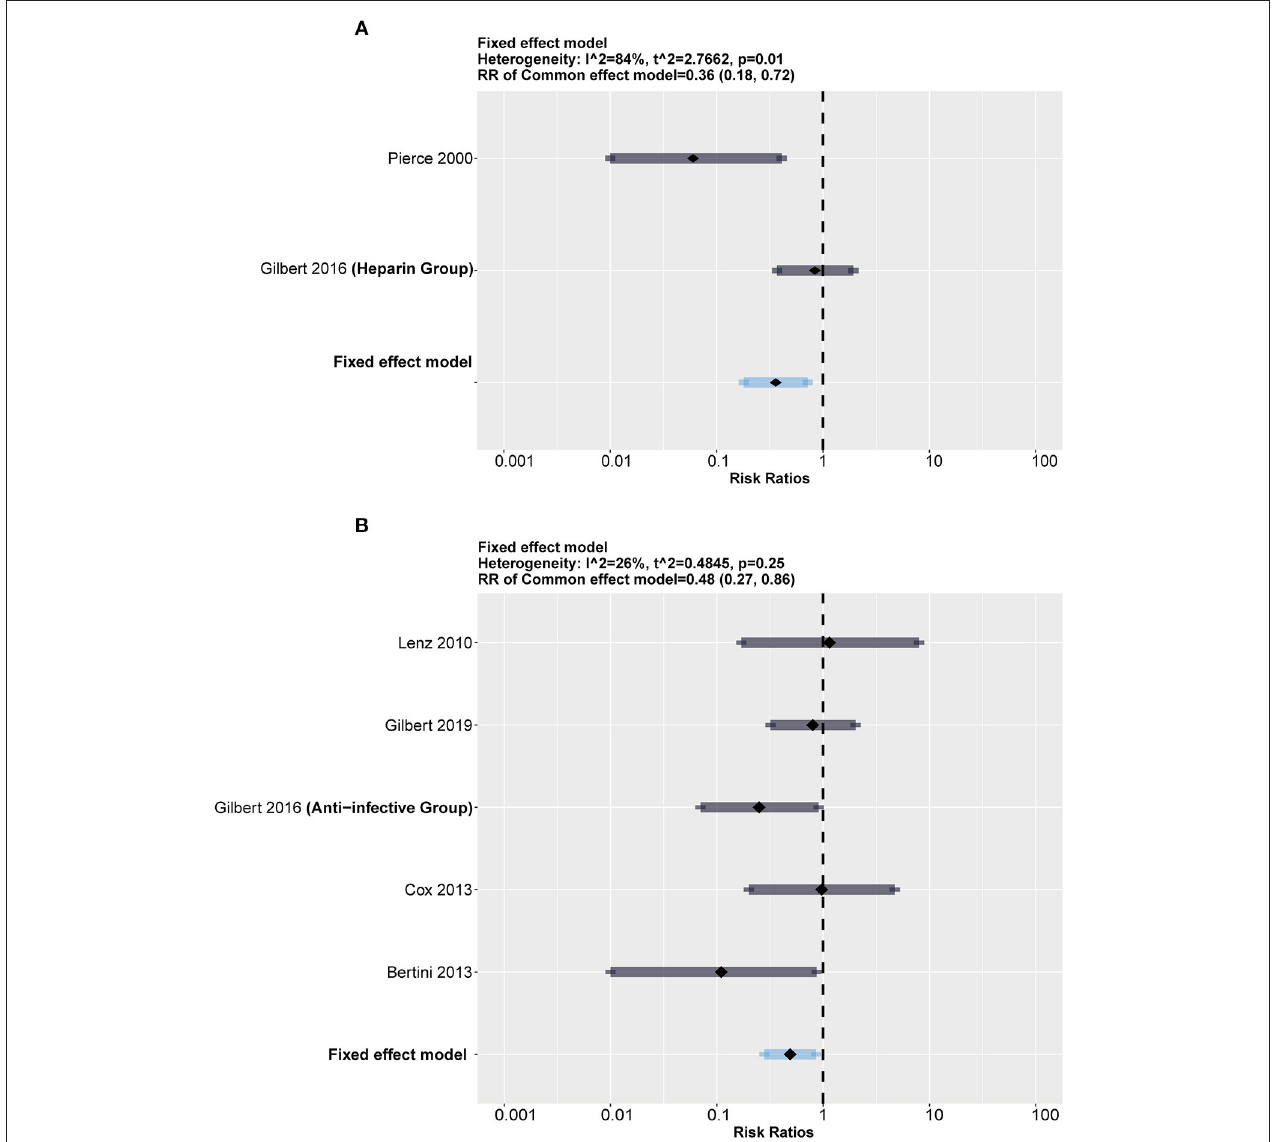
FIGURE 4 | Subgroup analysis between heparin and antimicrobial drugs. The forest showed a significant difference in both groups but a much higher heterogeneity in the heparin group than in the antimicrobial group. (A) Forest plot in heparin group (compared with standard). (B) Forest plot in antimicrobial group (compared with